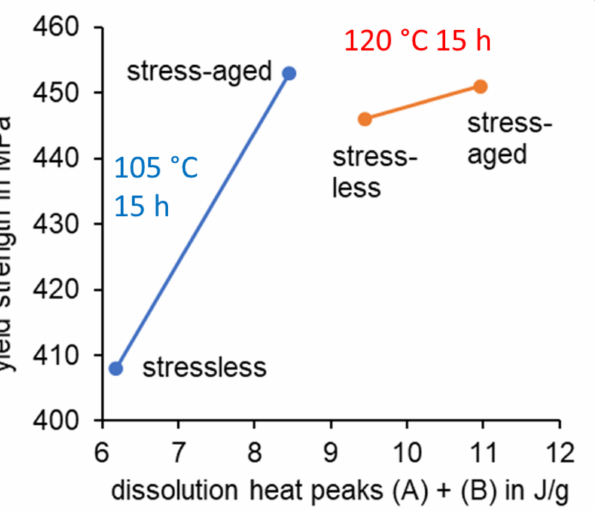
Figure 10. Correlation between yield strength and the summated dissolution heat of peaks (A) and (B), i.e., dissolution of GP and η (cid:48) ; stressless and stress-aged samples were considered, superimposed stresses were 0 MPa and 200 MPa,